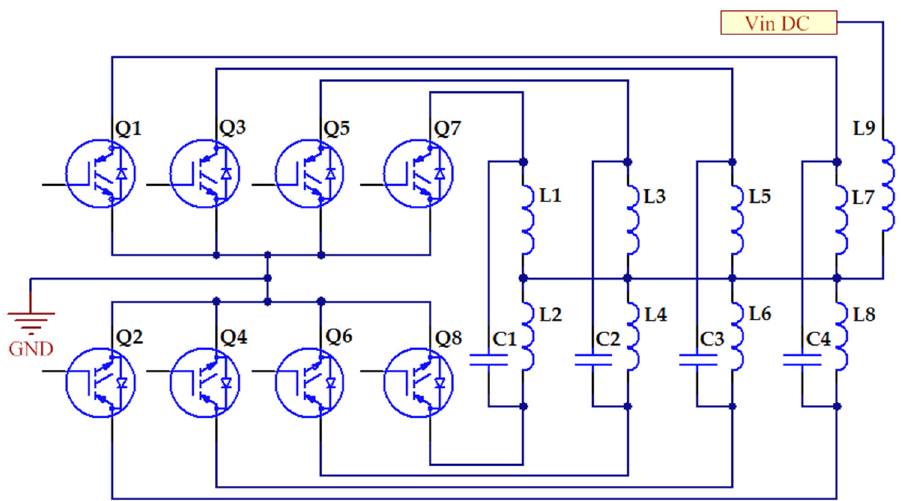
Figure 15. A suggested structure of connection.